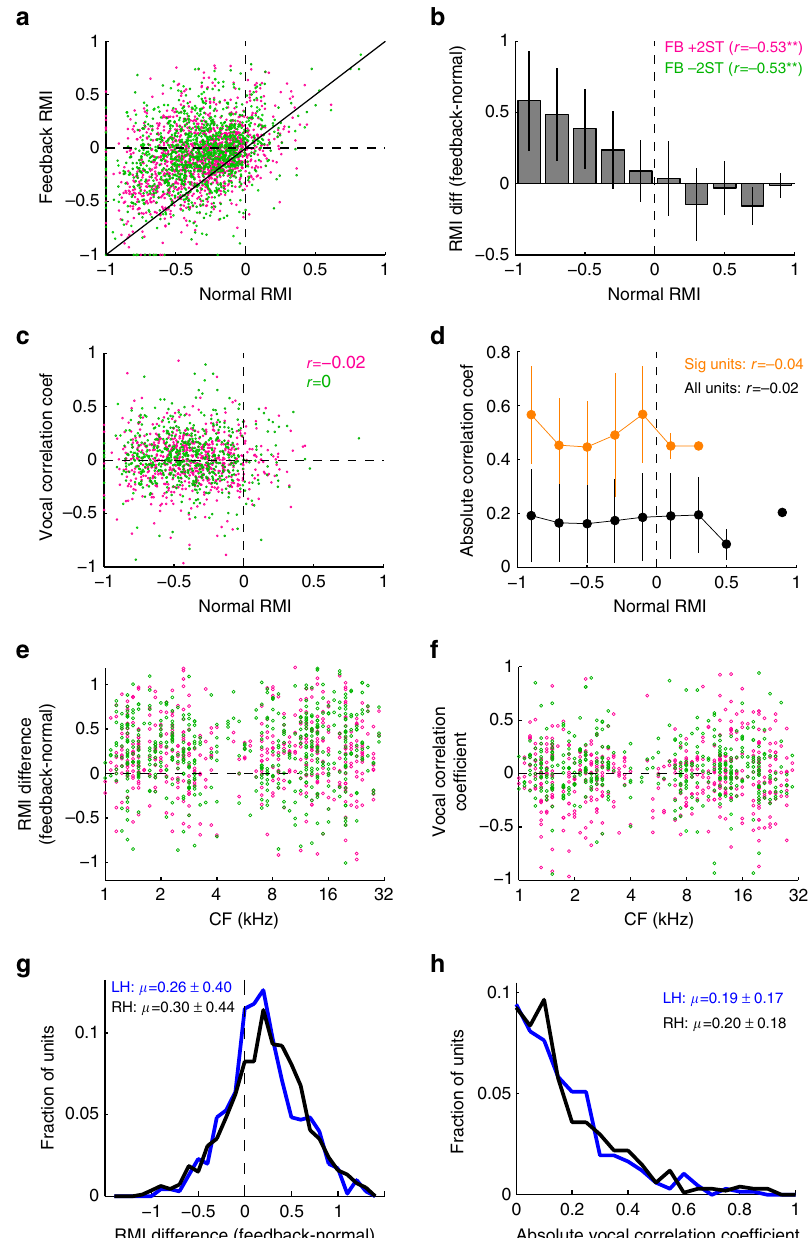
Fig. 6 Comparison between vocal suppression and compensation predictions. a Scatter plot comparing unit vocal responses (RMI) during normal and shifted feedback showing decreased suppression across units. Equal value line (unitary slope) is indicated. FB + 2ST evoked an increase in activity compared to normally suppressed vocal responses (RMI change: 0.24 ± 0.31, mean ± std; p < 0.001, Wilcoxon signed-rank), as did FB − 2ST (0.27 ± 0.37; p < 0.001). b Feedback effects plotted as mean Feedback-Normal RMI differences and binned by RMI. Suppressed units (RMI < − 0.2) exhibited larger feedback increases than excited units (RMI > 0) which showed more balance effects. This trend of larger activity increases in suppressed units was present for both + 2ST ( r = − 0.53, p < 0.001) and − 2ST ( r = − 0.53, p < 0.001) feedback. (Error bars: standard deviation) c Scatter plot comparing vocal correlation coef fi cients and vocal suppression, showing no obvious relationships ( + 2ST: r = − 0.02, p = 0.65; − 2ST r = 0, p = 0.97). d Mean vocal correlation coef fi cients binned by RMI, shown separately for all data (black) and for only units with signi fi cant correlations (orange). e , f There was also no obvious relationship between frequency tuning (CF) and feedback effects ( e ) or vocal correlation coef fi cients ( f ). g , h , Histograms comparing feedback effects ( g ) and vocal correlation coef fi cients ( h ) between hemispheres (RH: right, LH: left). The right hemisphere showed a slight increase in feedback sensitivity over the left ( p = 0.02, Wilcoxon rank-sum), but there were no differences for vocal correlation ( p = 0.84). Sample sizes and statistical